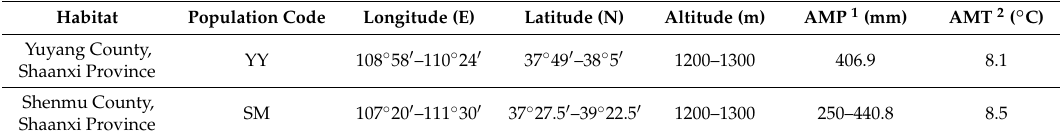
Table 1. The basic layout of seed sampling points for experimental materials.